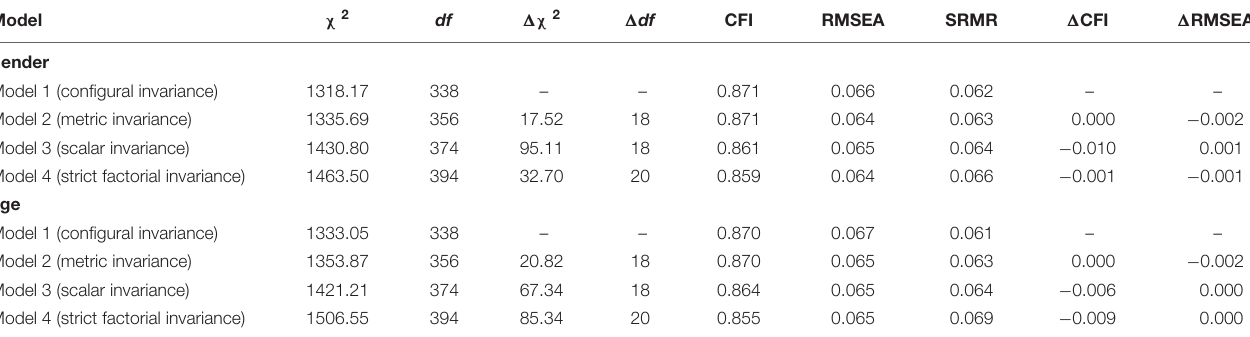
FIGURE 2 | Plot of the standardized mean scores on the negative subscale across the three latent profiles. TABLE 8 | Measurement invariance: multigroup CFA fit indices across gender and age groups.